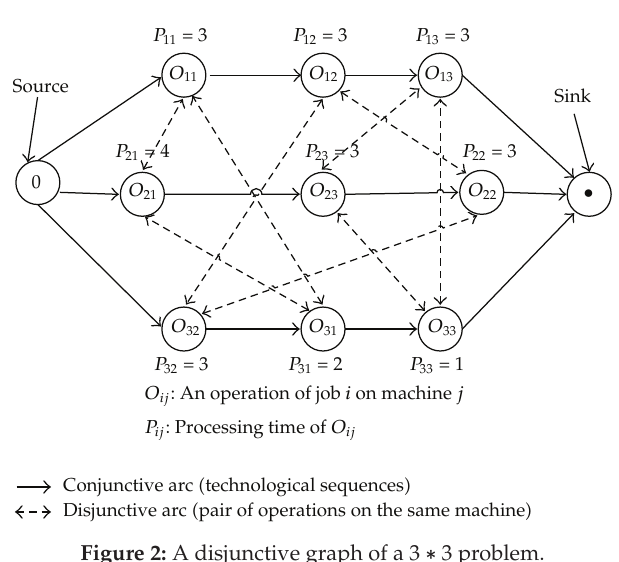
Figure 2: A disjunctive graph of a 3 ∗ 3